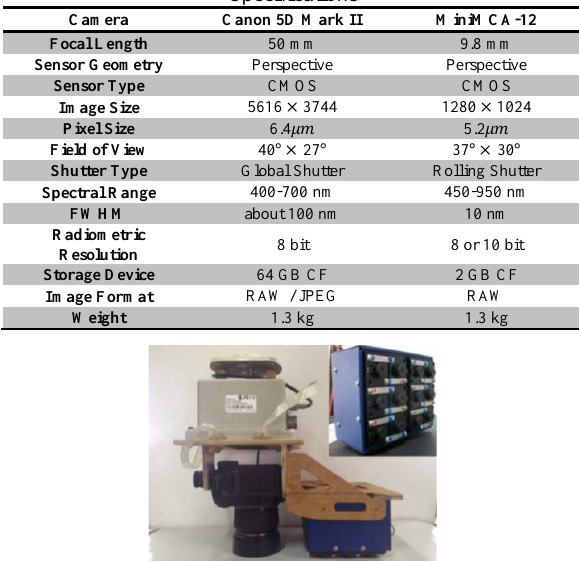
Figure 2. Canon 5D Mark II and MiniMCA-12 (upper-left inset) mounted with POS